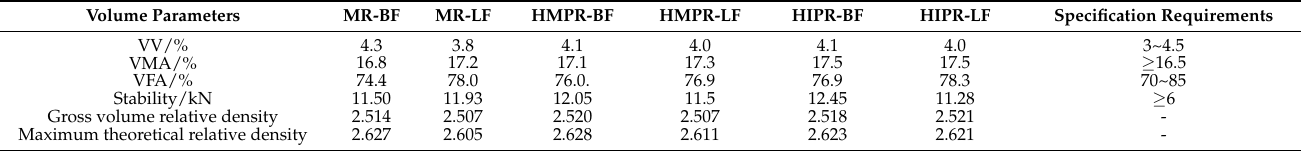
Table 9. Volumetric parameters of aggregate gradations.